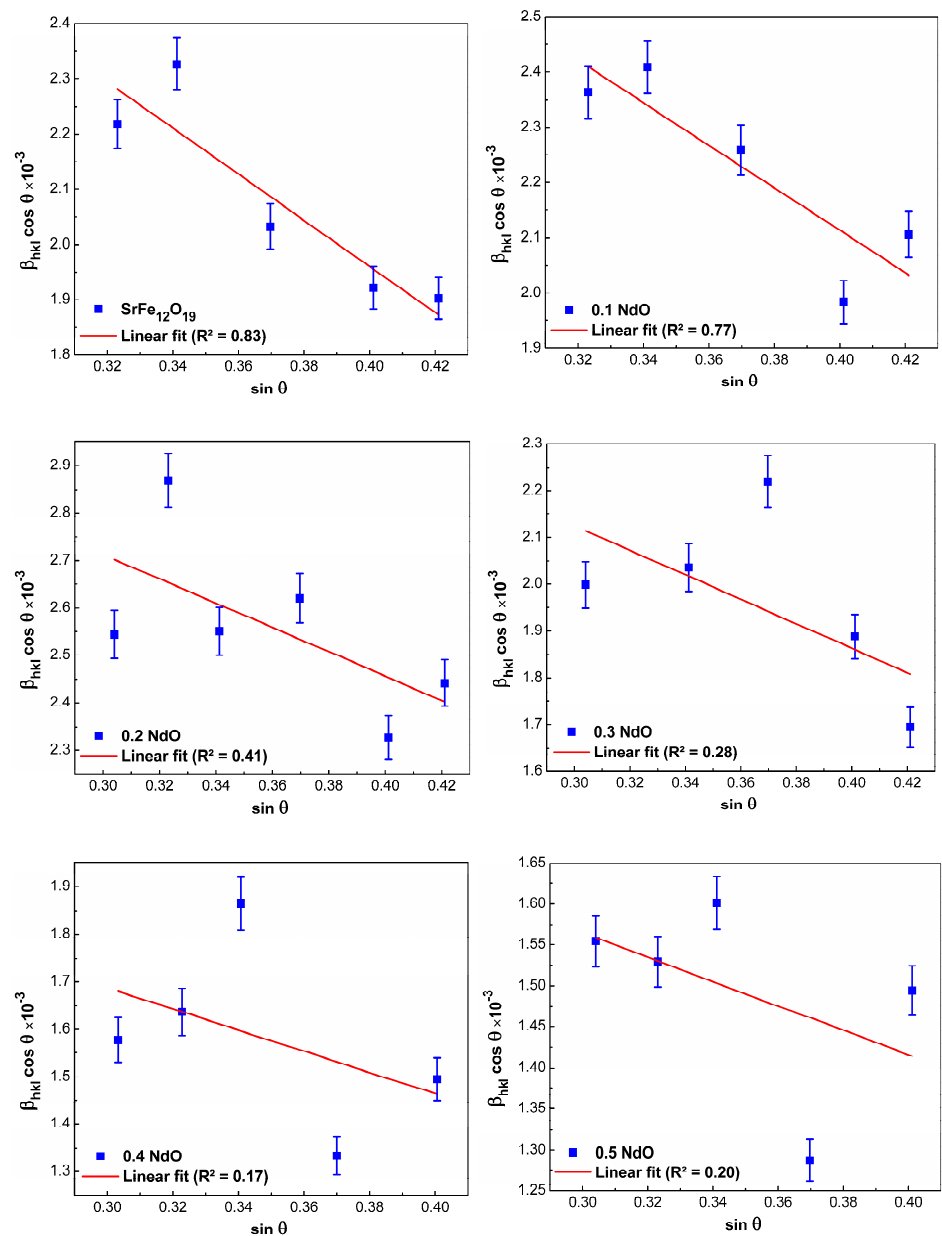
Figure 4. Williamson–Hall plots for hexaferrite powders SrFe 12-x Nd x O 19 (0 ≤ x ≤ 0.5).